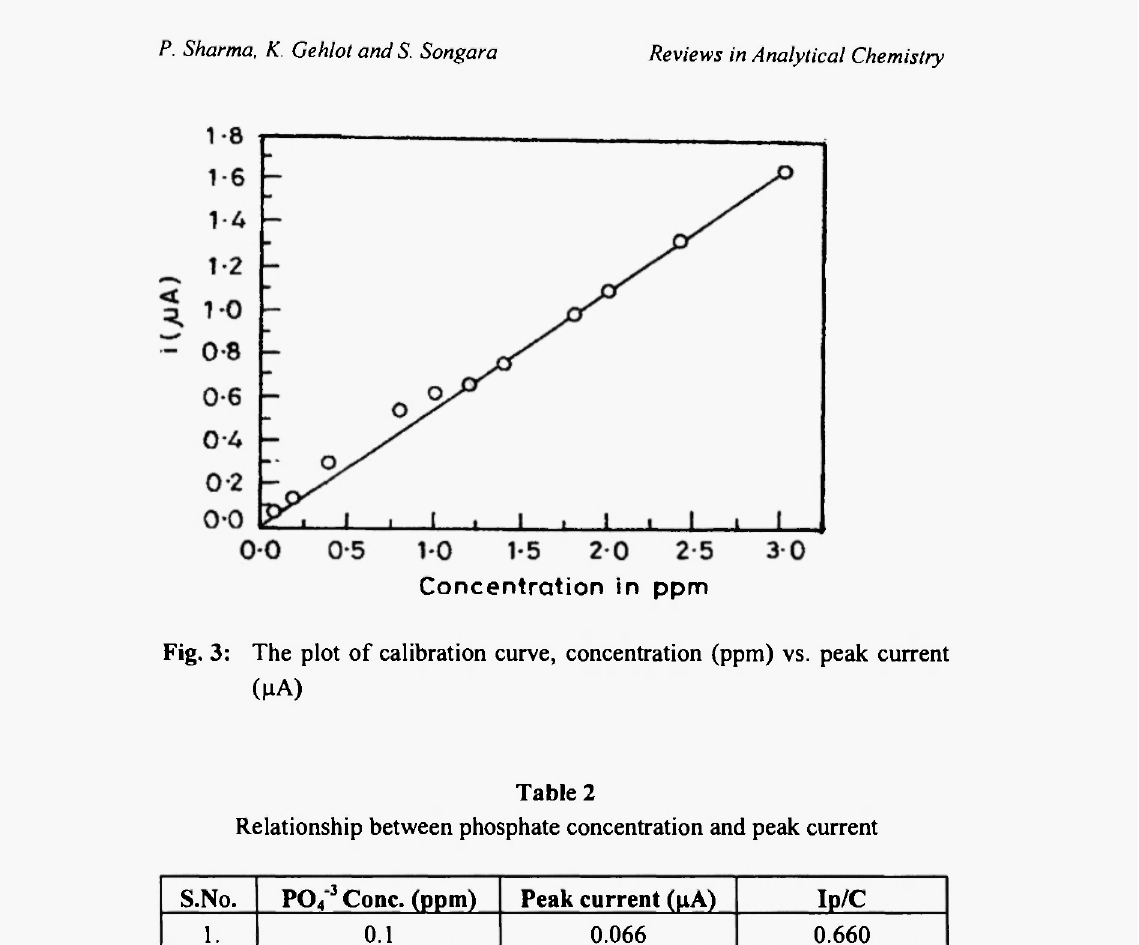
Relationship between phosphate concentration and peak current